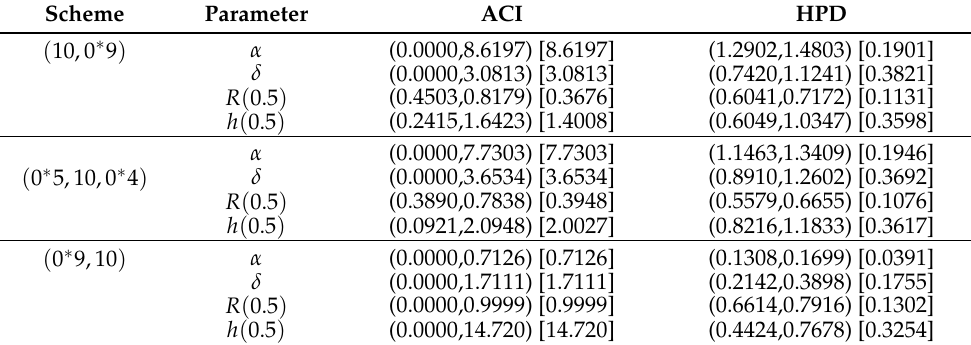
Table 7. The interval estimates [lengths] of α , δ , R ( t ) and h ( t ) using electrical appliances data.